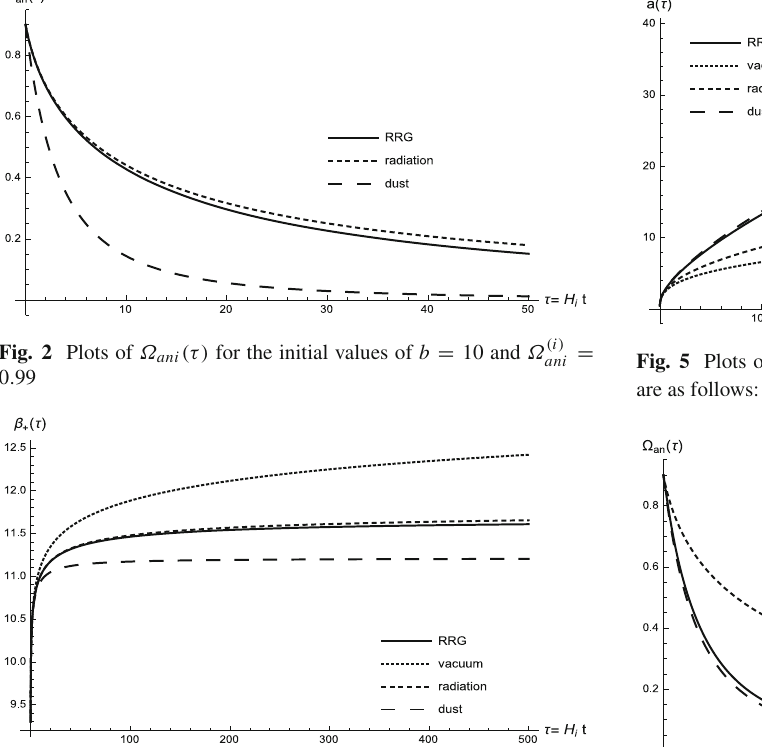
= Fig. 4 Plotsof β − correspondingtotheparameters b = 10and Ω ( i ) ani 0 . 99, while the initial condition β − = 15